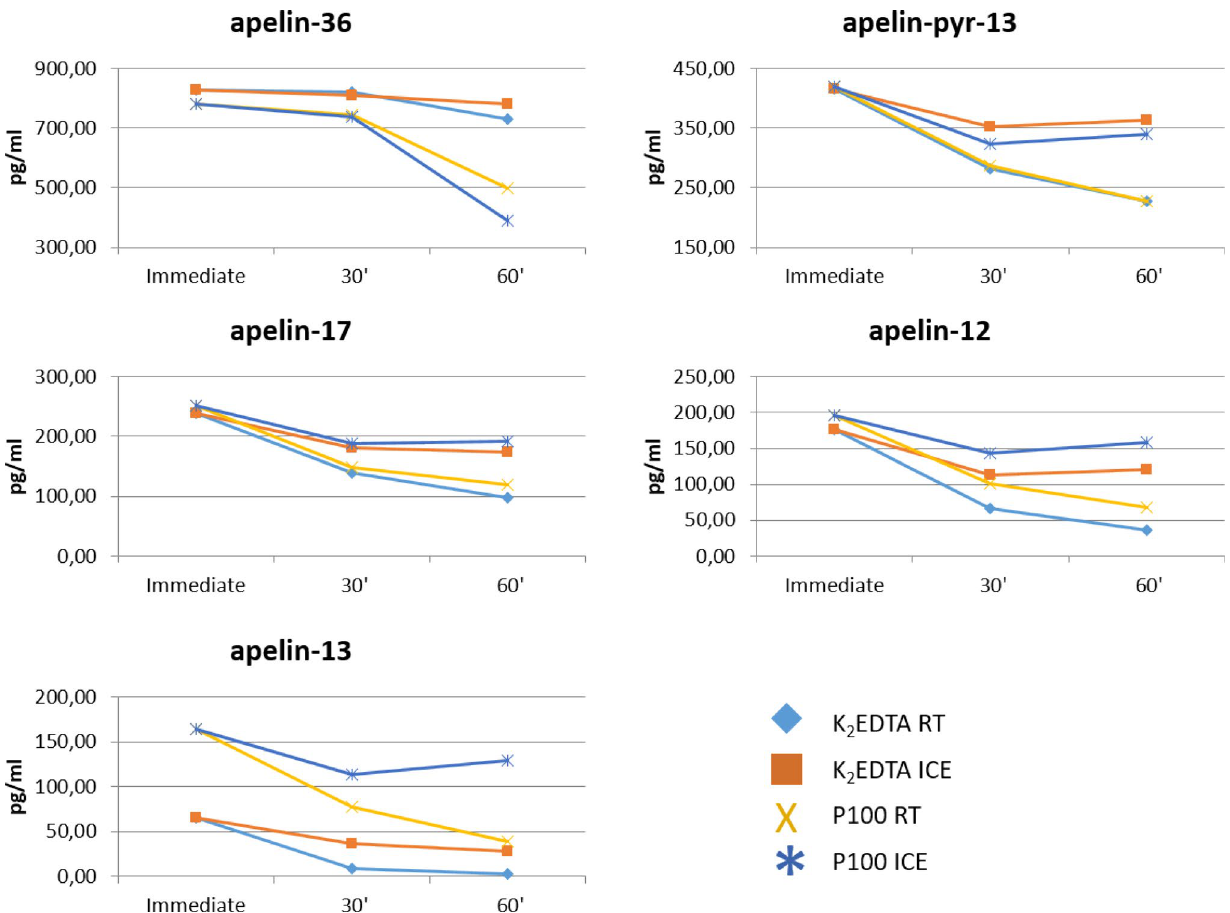
Figure 7. Influence of cooling on ice and P100 protease inhibitor cocktail on peptide stability in whole blood before centrifugation. Cooling with ice has the largest impact on stability, with limited added value of the P100 tube. Only for apelin-13 there a small added value in terms of stability due to the P100 tube was observed. For apelin-36, the P100 tube seems to have a negative influence. P values after Kruskal–Wallis tests for the difference between last and first time point: apelin-36: P = 0.023; apelin-17: P = 0.039; apelin-13: P = 0.270; apelin-pyr-13: P = 0.238; apelin-12: P =